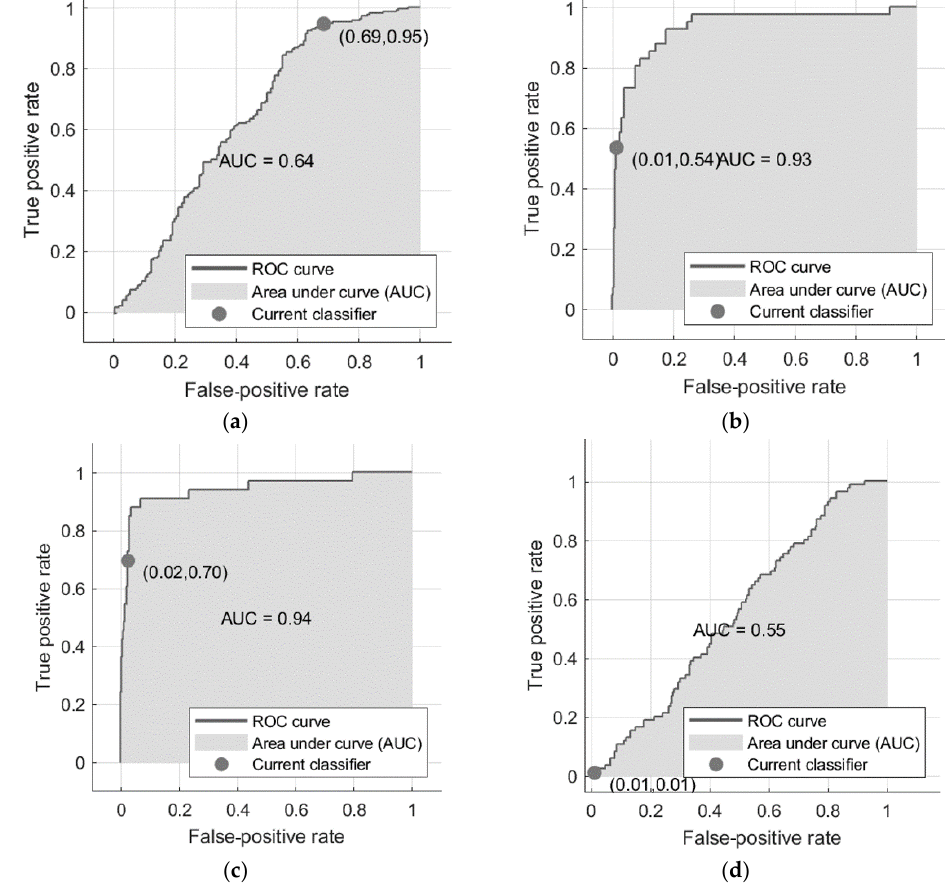
Figure 5. ROC curves of the classification algorithm with the best accuracy (SVM with Gaussian kernel). ( a ) Cable insulation failure vs. all other classes; ( b ) excavation damage vs. all other classes; ( c ) secondary substation busbar failure vs. all other classes; ( d ) joint failure vs. all other classes.